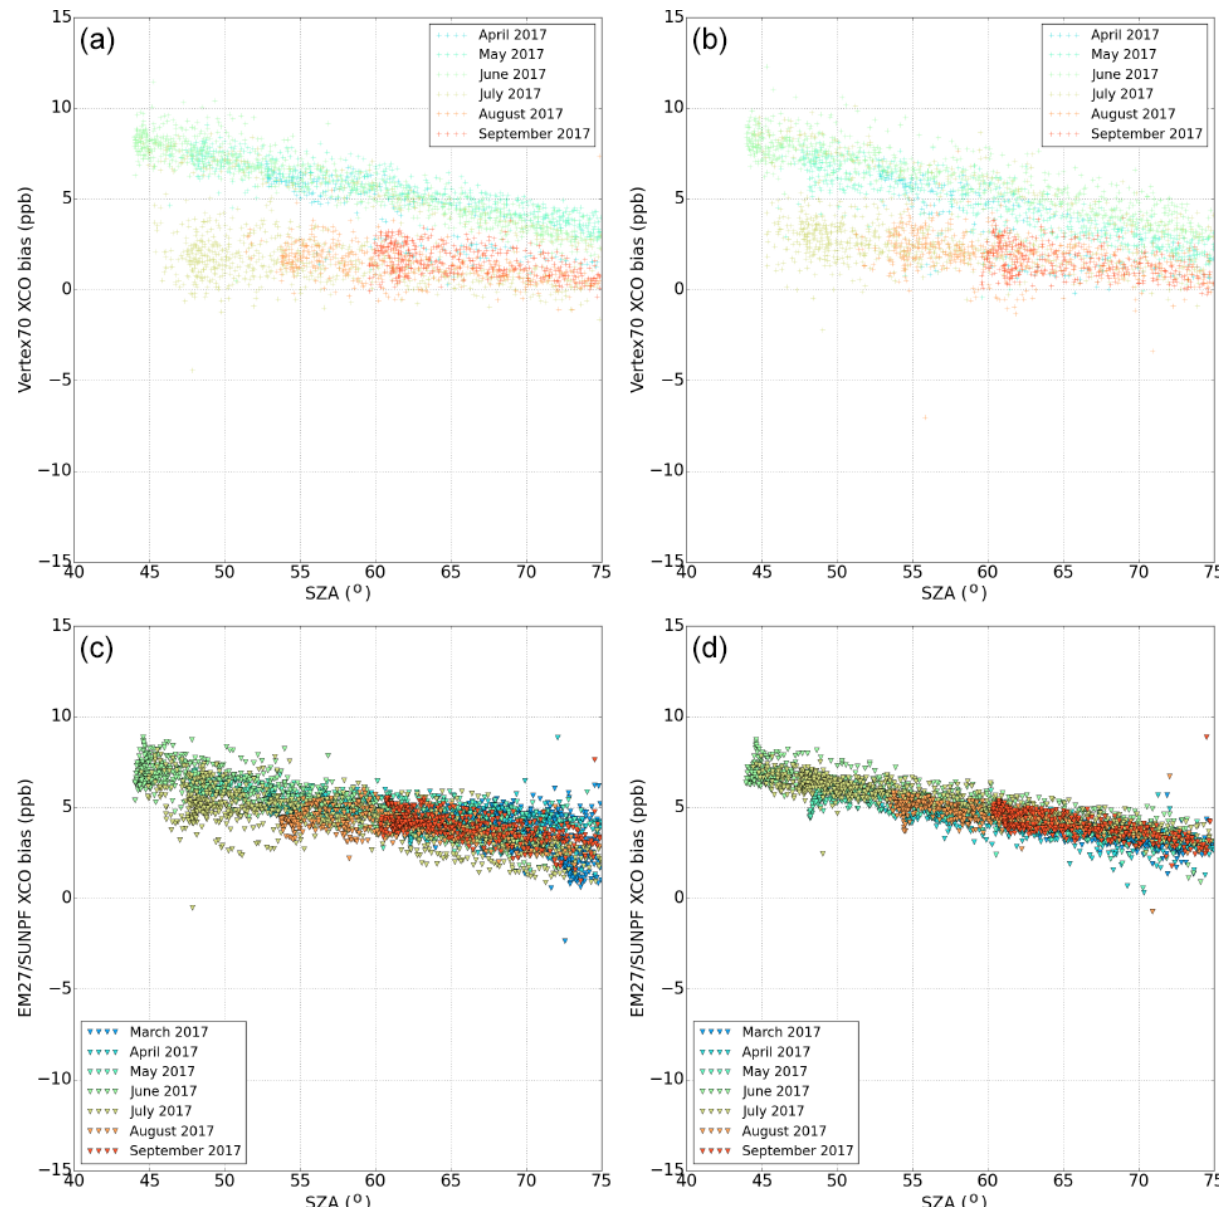
Figure E4. XCO bias relative to TCCON (a, c) and relative to HR125LR (b, d) for each instrument plotted with respect to the solar zenith angle: Vertex70 (a, b) and EM27/SUN (c, d) . The colours represent the measurement performed during the different months of the